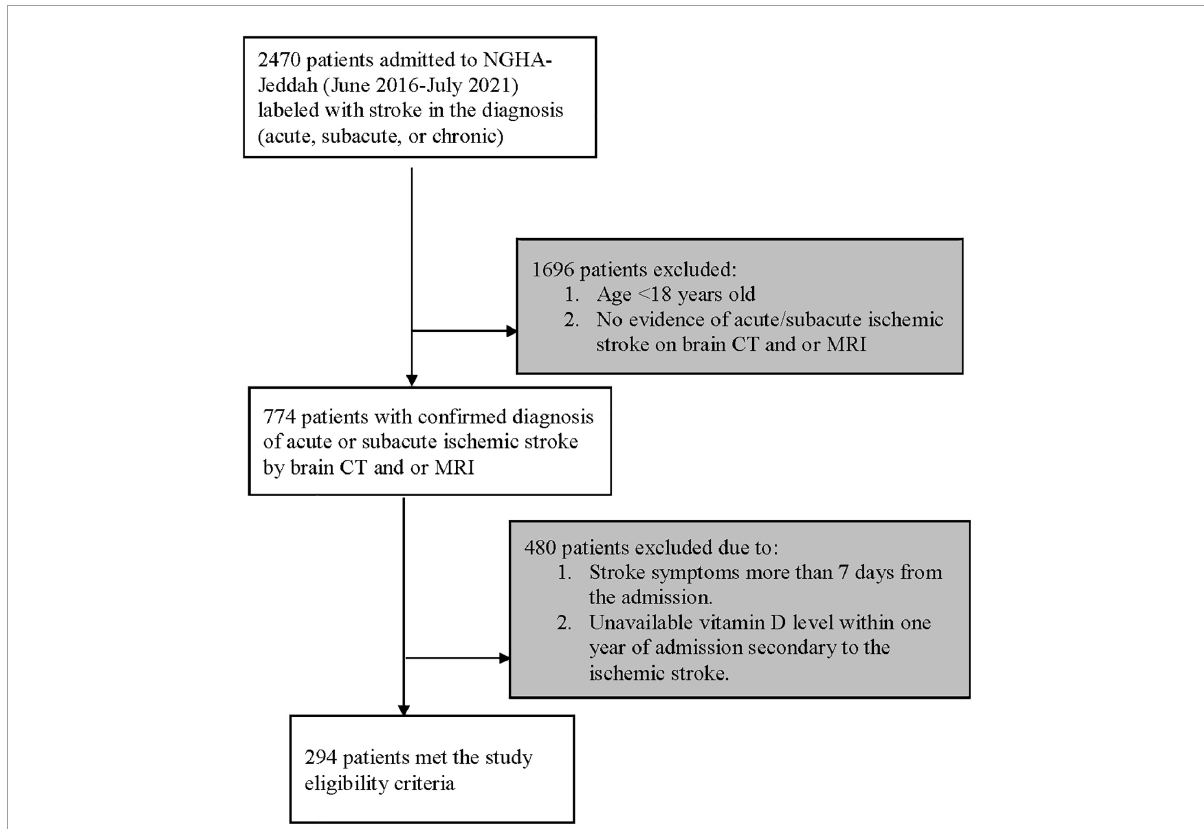
FIGURE1 Flow diagram showing patients recruited with ischemic stroke. NGHA, National Guard Health Affairs; CT, Computerized tomography; MRI, Magnetic resonance imaging.